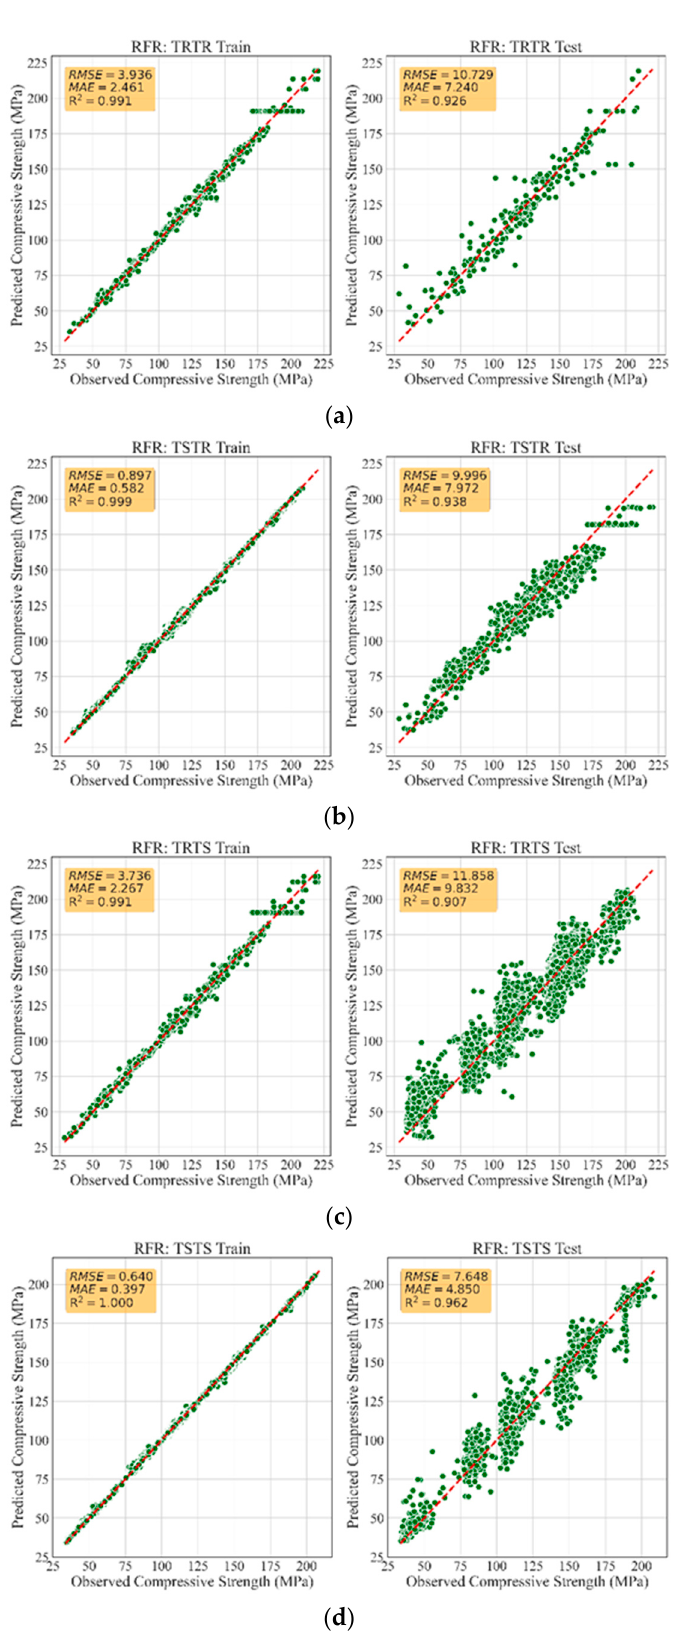
Figure 3. Training and testing performance of RFR model: ( a ) TRTR; ( b ) TSTR; ( c ) TRTS, and ( d ) TSTS.